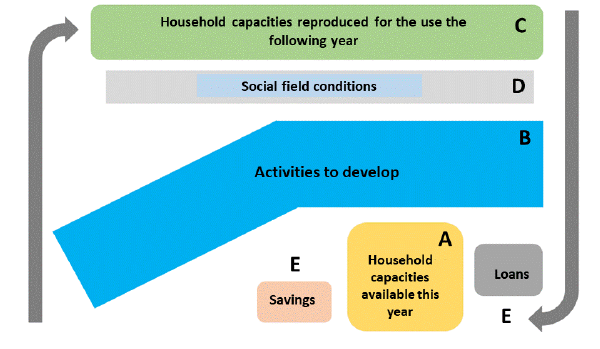
Fig. 2. Basic cyclic structure of the board game, which may be adapted to other rural contexts by varying its parameters. (A) Players have a set of capacities to be assigned to several of the eight different activities. (B) Players choose among the activities, which require different levels of the capacities. (C) Each activity generates one capacity to be used in the following year. (D) The social fields (or dice) represent the probability of a rural household’s success or failure in generating capacities resulting from each activity selected as a result of ecological, political, and market uncertainties. (E) Players may spend their savings for a “wild card” token or take a loan from a local loan